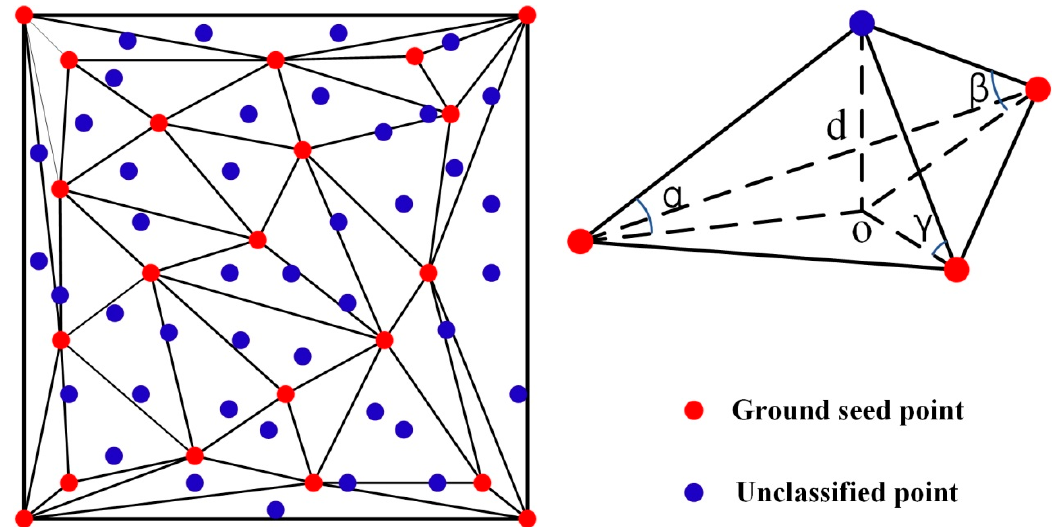
Figure 3. Schematic diagram of ATIN.